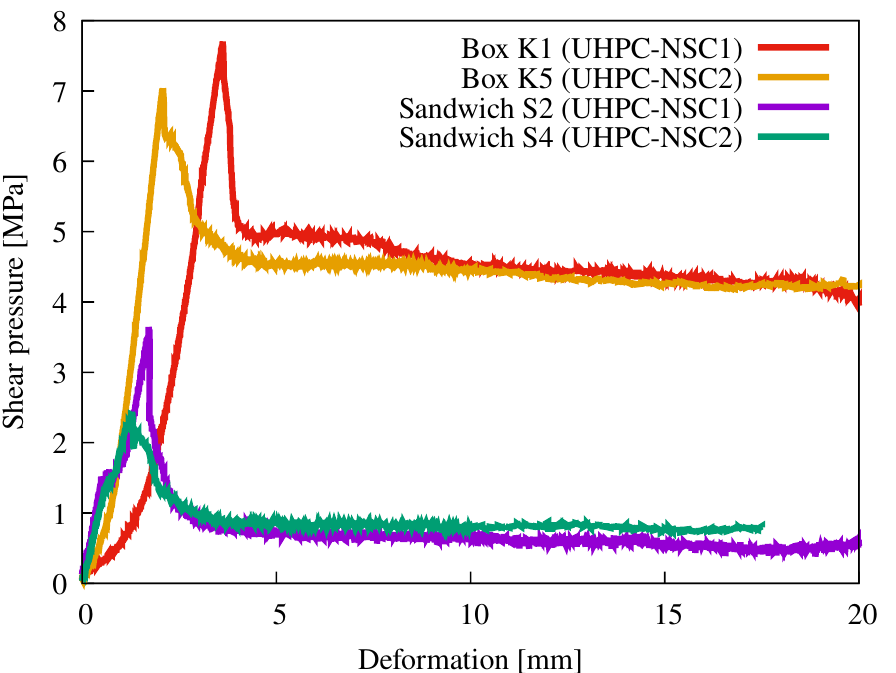
Figure 11. Typical graphs of shear pressure vs. deformation for box and sandwich samples for both types of material interface. The slope of the curves (red and yellow) is affected by a wooden plate placed between the sample and metal surface of the hydraulic loading machine to prevent unwanted damage of the top part of the